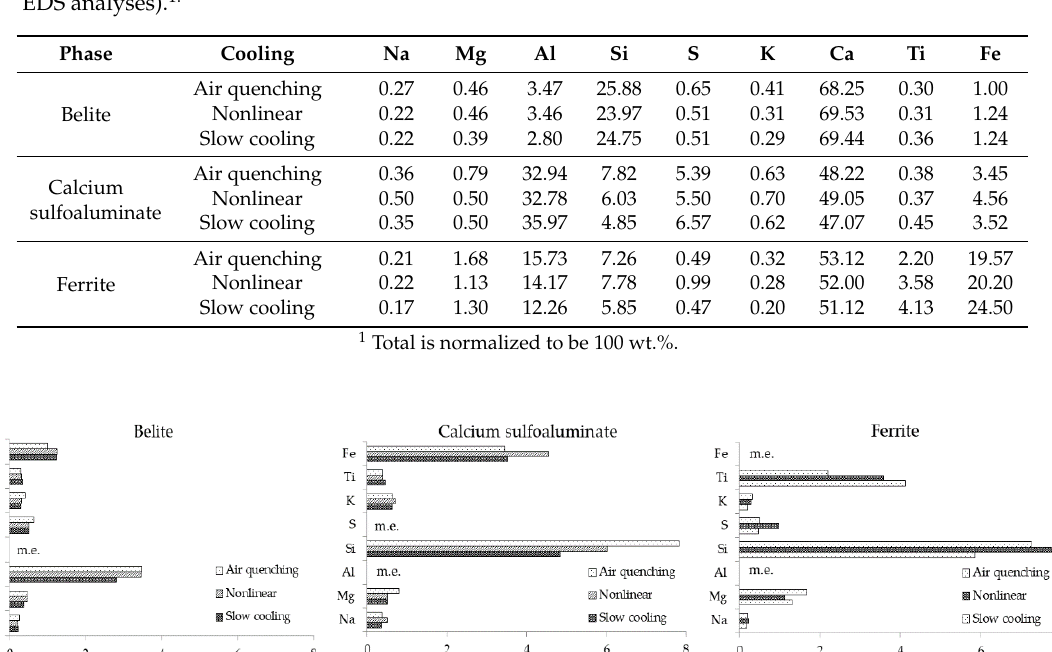
Table 4. Average chemical composition (wt.%) of the main phases in the clinkers (determined by EDS analyses). 1.